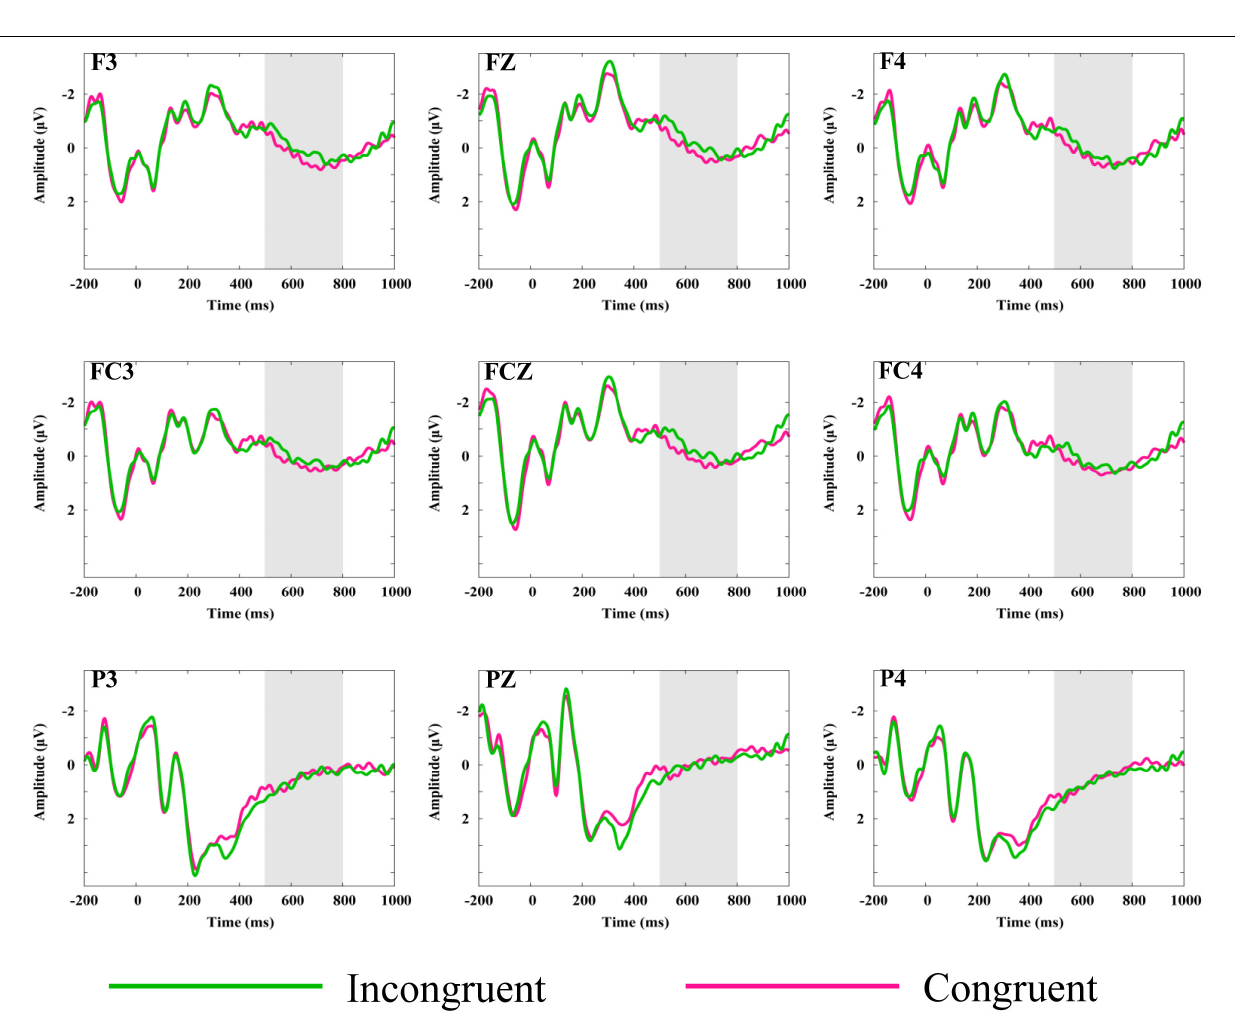
FIGURE 4 | Grand mean ERP waveforms elicited by the reappearance of the stadium preceded by congruent or incongruent narratives. Gray-shaded areas indicate the time windows used for statistical analysis. F3, FZ, F4, FC3, FCZ, and FC4 showed larger amplitude of LPP for congruent trials than in congruent trials, while P3, PZ, and P4 showed no significant difference between the two